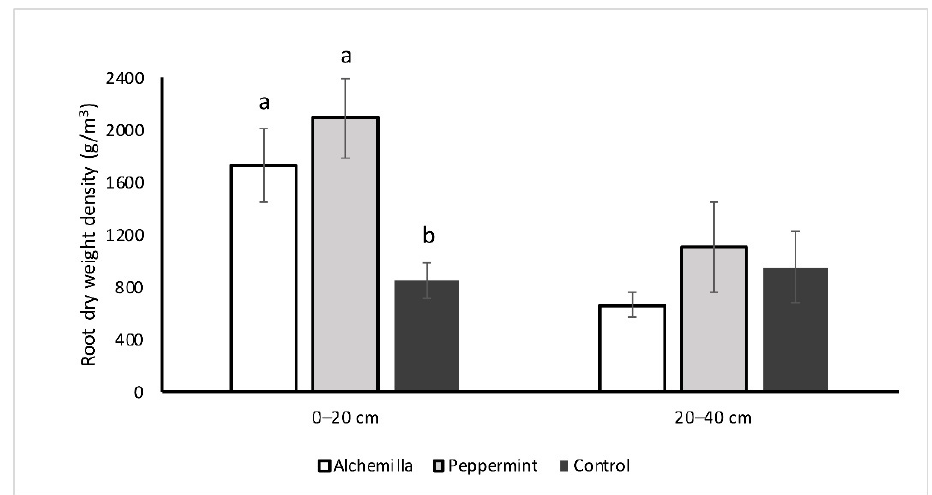
Figure 4. Effect of the interaction between living mulch treatment and soil depth on root dry weight density (g/m 3 ). Bars represent SEM.